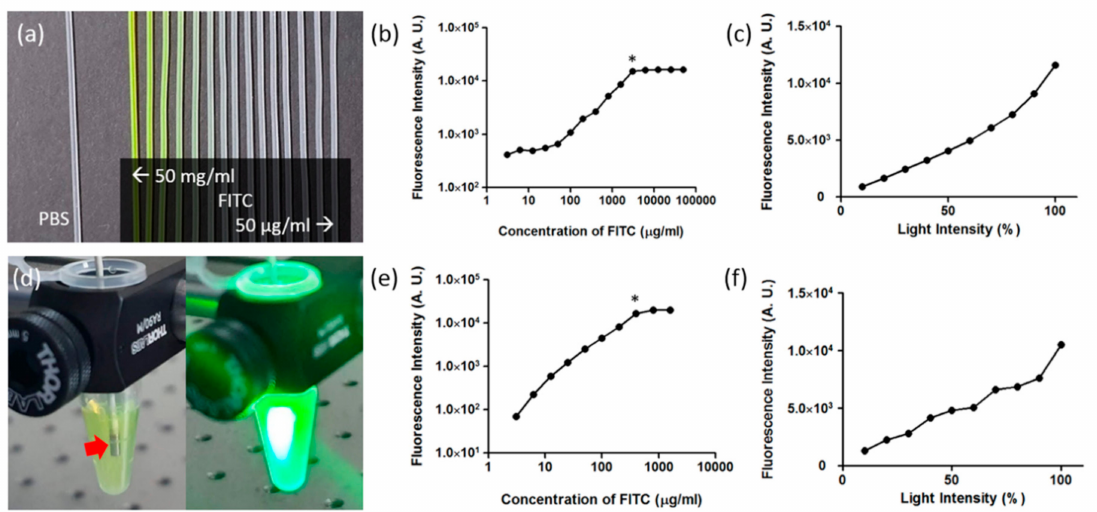
Figure 2. Results of the phantom test of DSFE. ( a ) Photography of phosphate bu ff ered saline and 15 di ff erent concentrations of fluorescein isothiocyanate (FITC)-contained silicone tubes. ( b ) The concentration-dependent fluorescence signal of FITC measured via WFE. ( c ) The fluorescence signal of FITC according to excitation light intensity via WFE. ( d ) FITC-contained tubes with and without excitation light emitting from the CFEM probe (red arrow) (e) The concentration-dependent fluorescence signal of FITC measured via CFEM. ( f ) The fluorescence signal of FITC according to excitation light intensity via CFEM.